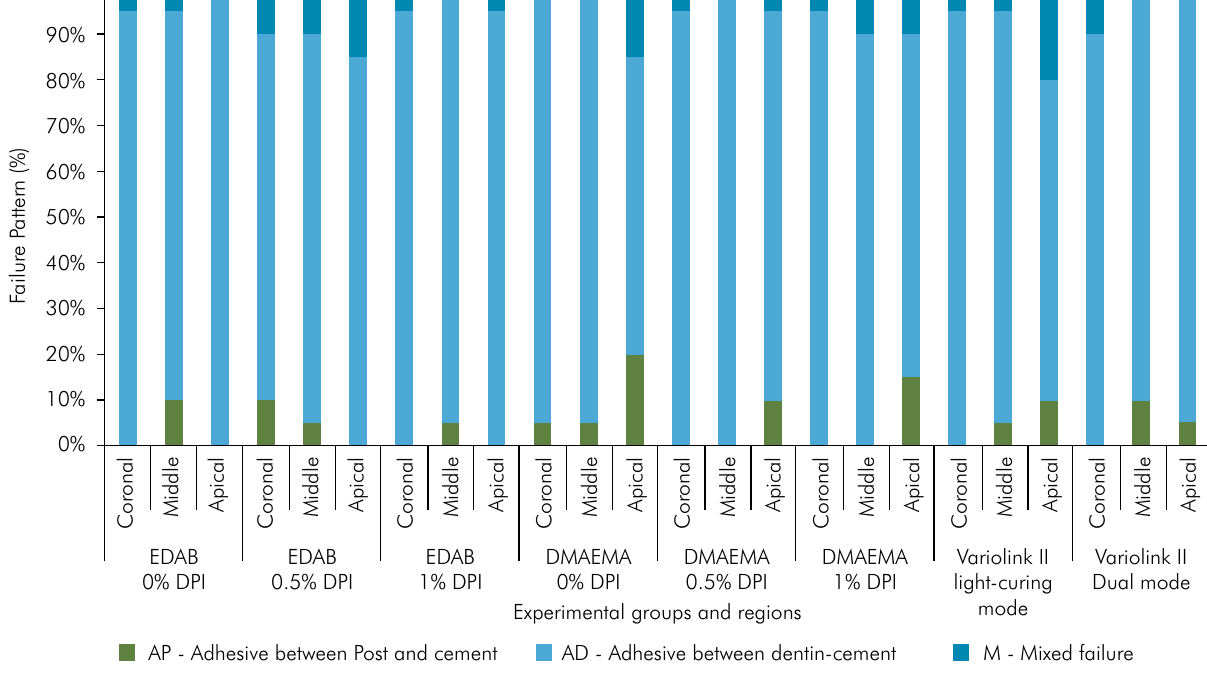
Figure. Distribution of the failure mode according to the experimental group and region